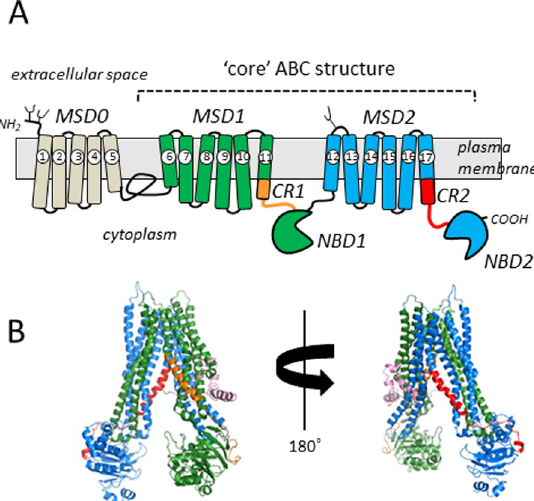
Fig 1. Models of human MRP1. (A) Shown is a two-dimensional illustration of the domain structure of MRP1, a so- called ‘long’ ABCC transporter [58]. MSD0 ( beige ) is present only in a subset of ABCC/MRP subfamily members and is connected to MSD1 by cytoplasmic loop 3 (often referred to as L o ). The core ABC domain structure is comprised of MSD1/NBD1 ( green ), CR1 ( orange ), MSD2/NBD2 ( blue ) and CR2 ( red ). The TMs of MRP1 are numbered 1–17, and the three N-glycosylation sites at Asn 19 , Asn 23 and Asn 1006 are indicated by small branches. (B) Shown are views of a homology model of the core human MRP1 structure [43] based on the cryo-EM structure of apo bovine Mrp1 (PDB ID: 5UJ9) at 0˚ and 180˚ rotation on a vertical axis so that CR1 ( orange ) and CR2 ( red ) are clearly visible. The colours of the other domains are the same as in panel (A) with a portion of cytoplasmic loop 3 between MSD0 and MSD1 coloured pink . MSD, membrane spanning domain; NBD, nucleotide binding domain; CR, connecting region.